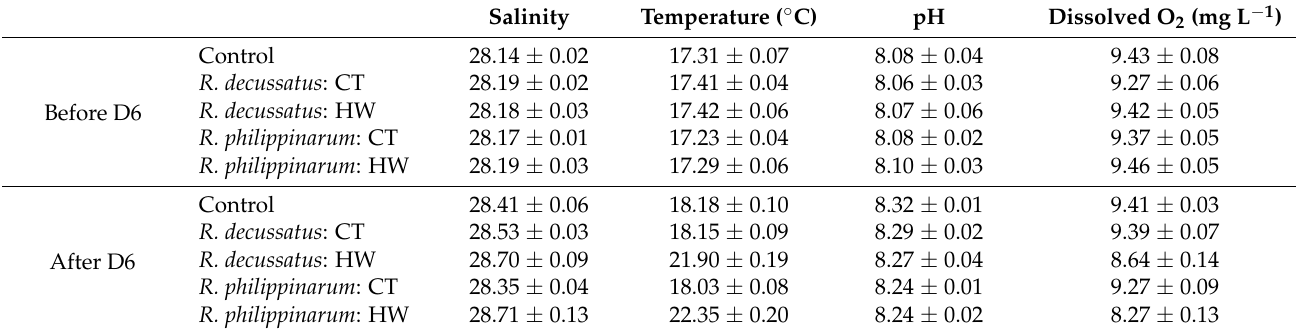
Table 1. Physicochemical conditions of the experimental units for each species (native Ruditapes decussatus and invasive R. philippinarum) and temperature treatments, before and after the introduction of the aquarium heaters at day 6 (mean ± SE). CT: constant temperature; HW: heat wave simulation.